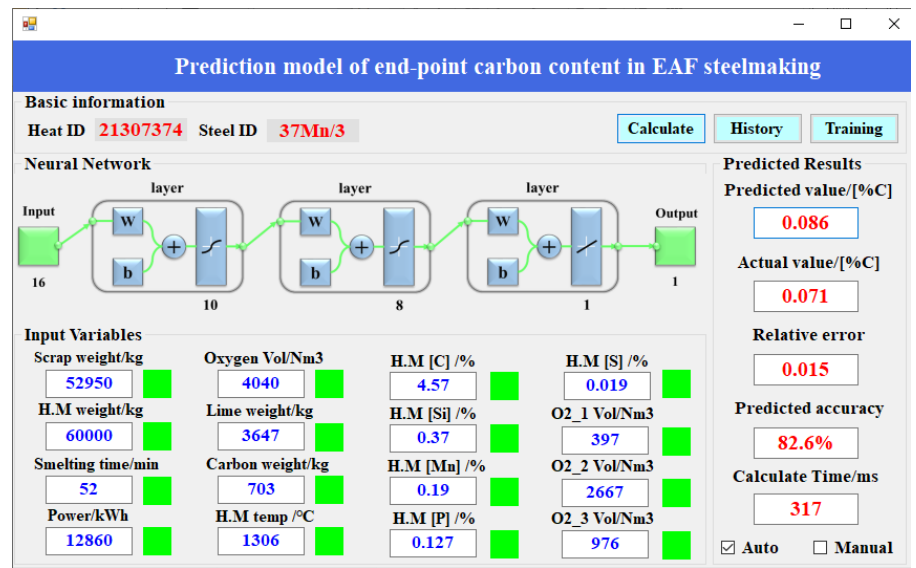
Figure 10. GUI of prediction model of end-point carbon content in EAF steelmaking.